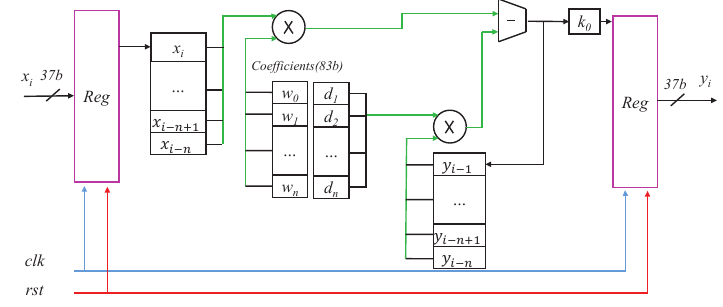
Figure 19. The hardware architecture of fractional